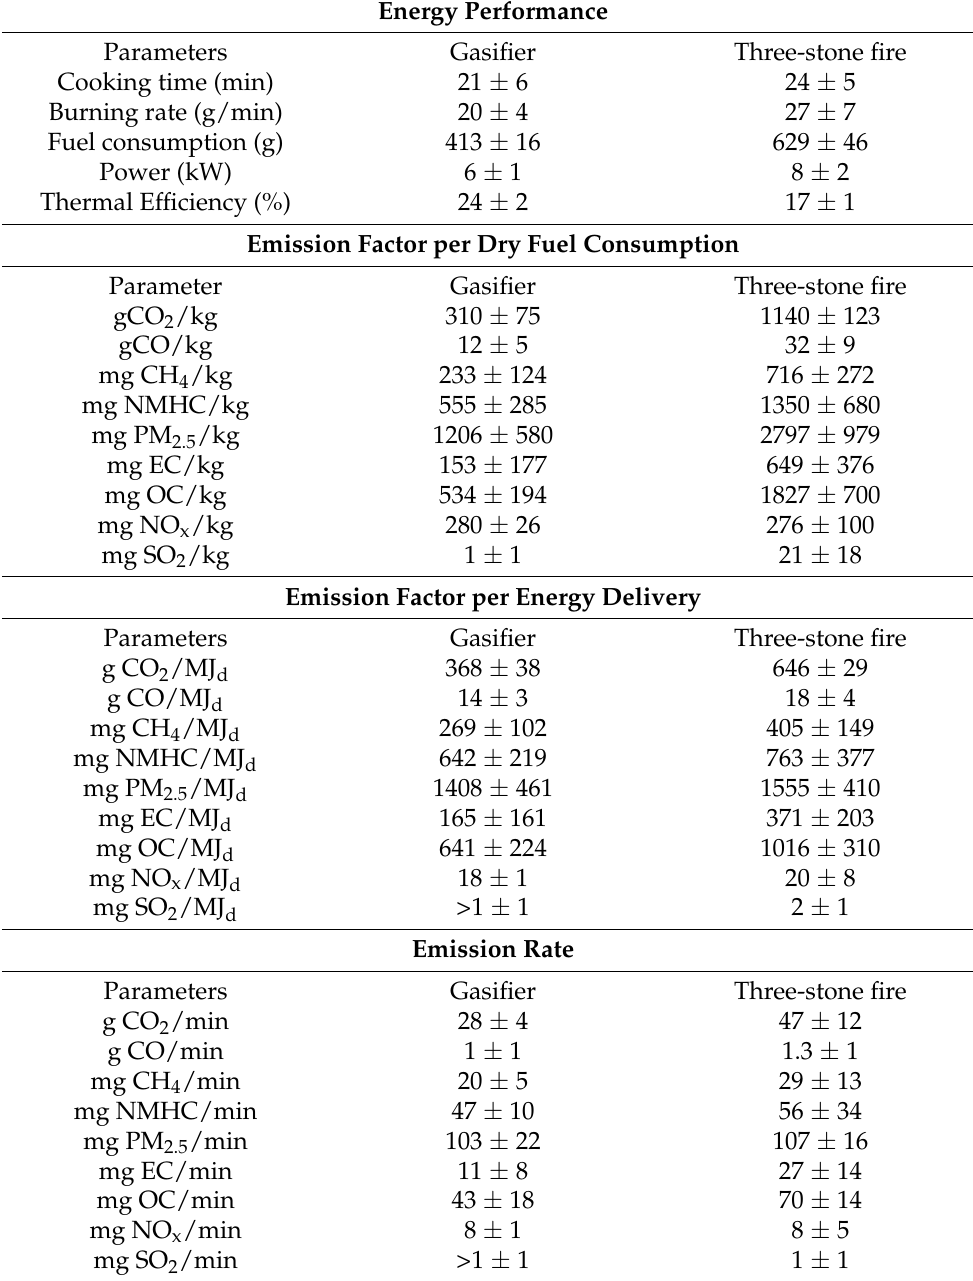
Table 3. Average energy and emission performance of briquette gasification and a three-stone fire fuelwood in a WBT (high